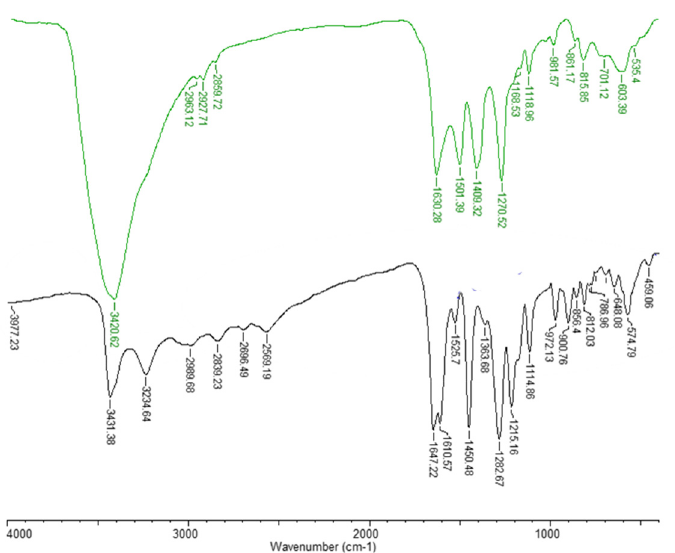
Figure 1. FT-IR spectra (registered in KBr pellets) for CFA (black) and Eu(III)-caffeinate (green).